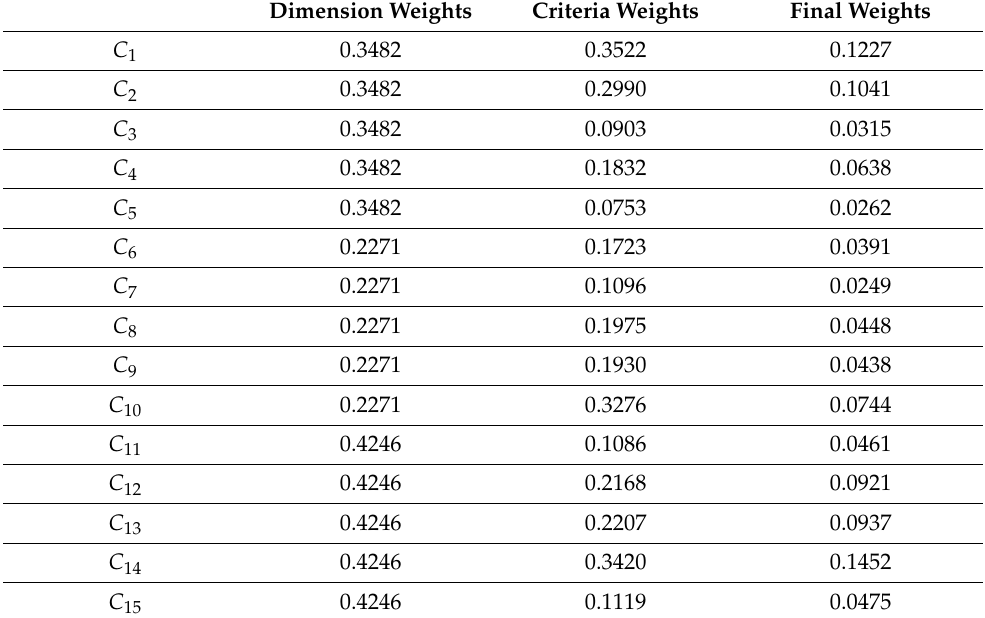
Table 4. Weight of each criterion after